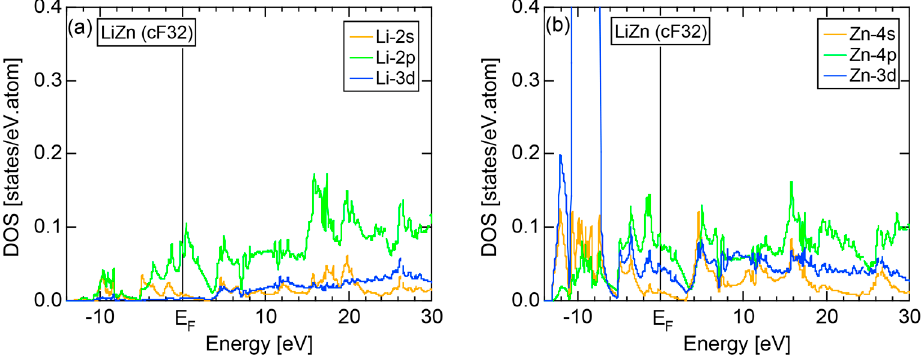
Figure 62. ( a ) Li- and ( b ) Zn-pDOSs for LiZn (cF32) [11,41].